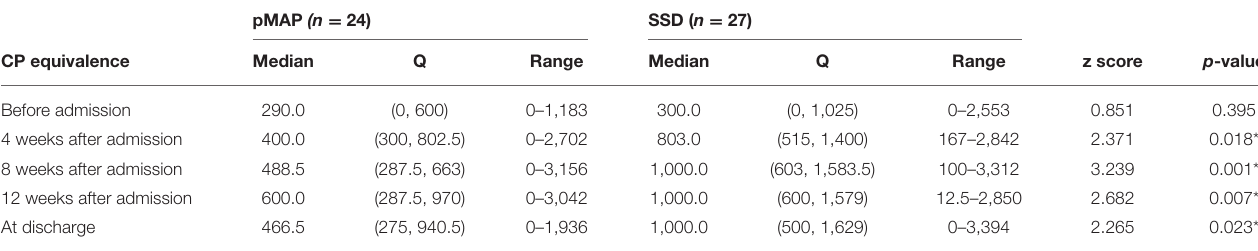
TABLE 3 | CP-equivalence value of pMAP and SSD patients in the medical prison.